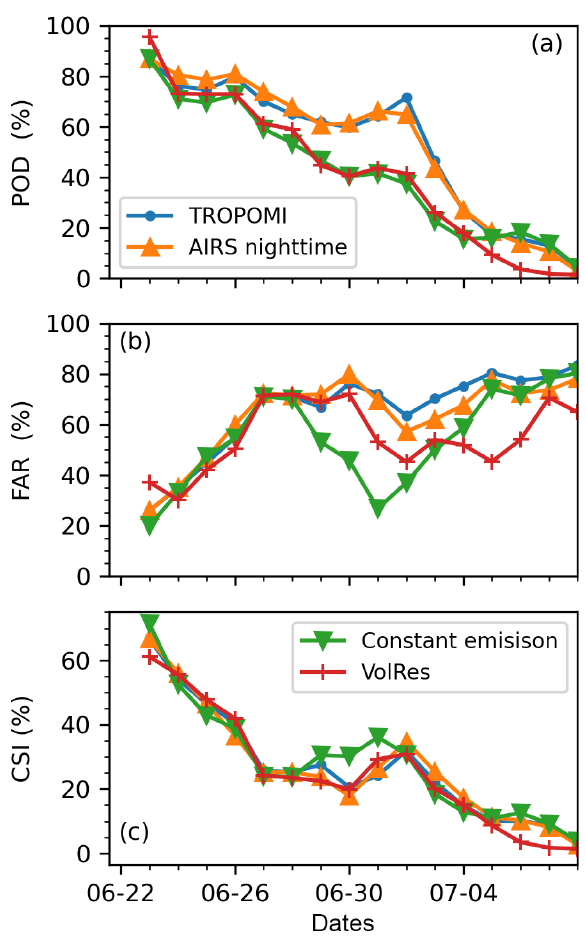
Figure 14. Time series of POD (a) , FAR (b) , and CSI (c) for forward simulations initialized by a constant injection rate (green) and the VolRes profile (red), as well as injection parameters recon- structed using TROPOMI (blue) and AIRS nighttime data (orange), respectively. The reference observations are TROPOMI retrievals. The column density threshold used to detect events is